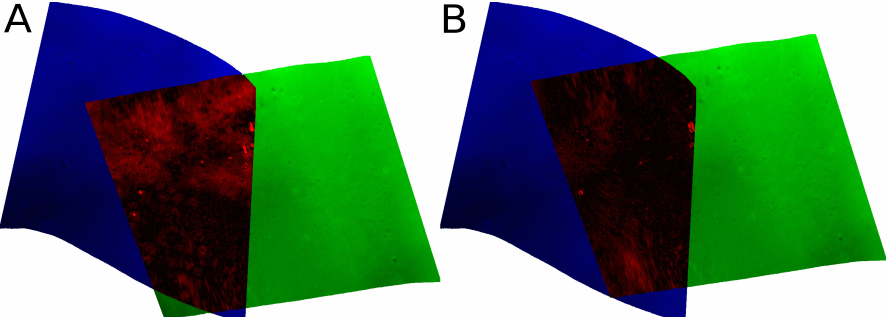
Figure 4. Example of a tile pair before ( A ) and after ( B ) navigation correction. Each image shows a tile pair with the heights color-coded in blue and green, respectively. The overlapping area shows the absolute difference between both tiles from black to red. These shifts are represented in Figure 3 as the center of the plot and the blue circle,